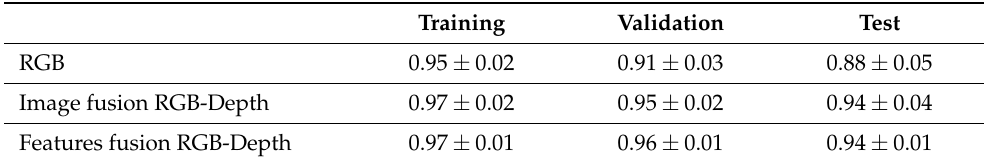
Table 2. Seedling growth stage classification average accuracy and standard deviation when per- formed over 10 repetitions of CNN model.